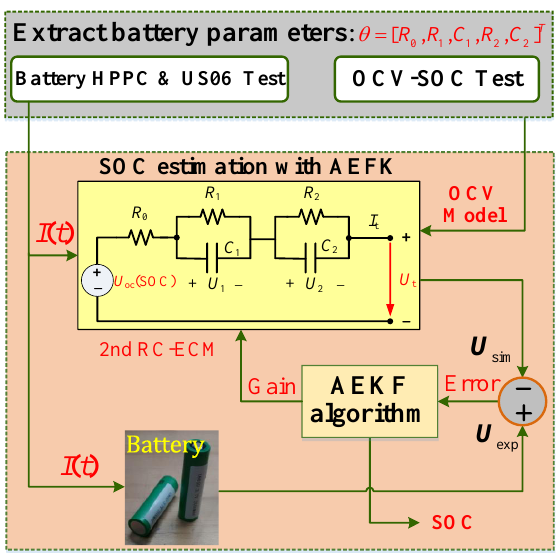
Figure 10. Flowchart of the SOC estimation logic.